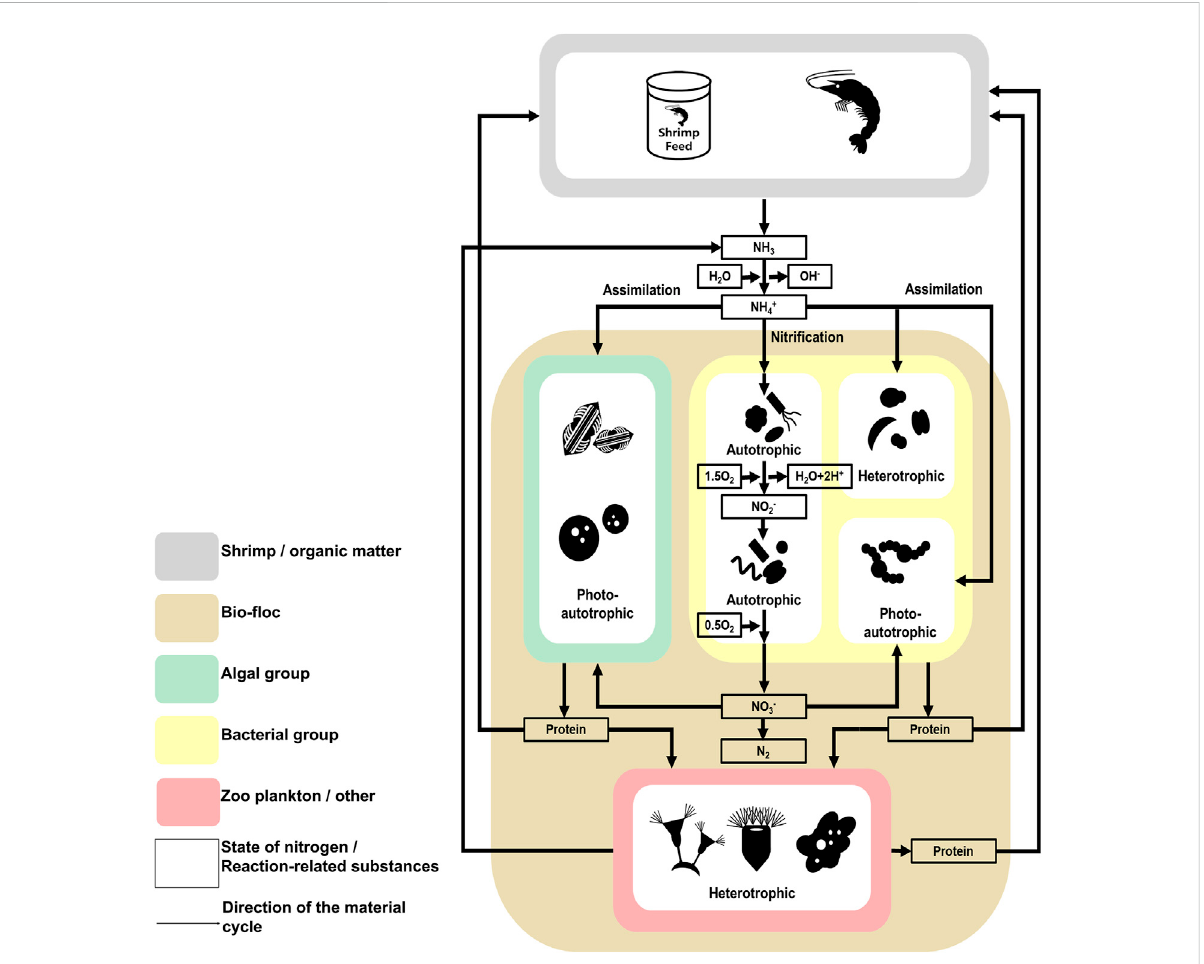
FIGURE 6 Theinvestigatedmodelofthenitrogencycleinthemicrobialcommunitiesfoundinthestudied Litopenaeusvannamei shrimpfarmwithbio fl oc technology. The nitrogen cycle followed in the studied Litopenaeus vannamei shrimp farms. Litopenaeus vannamei shrimp farms studied in bio fl oc technology. Physicochemical Characteristics of the Shrimp farm aquatic environment. The data underlying all the diagrams indicated in this fi gure can be found in Table 1 and Supplementary Tables S1,